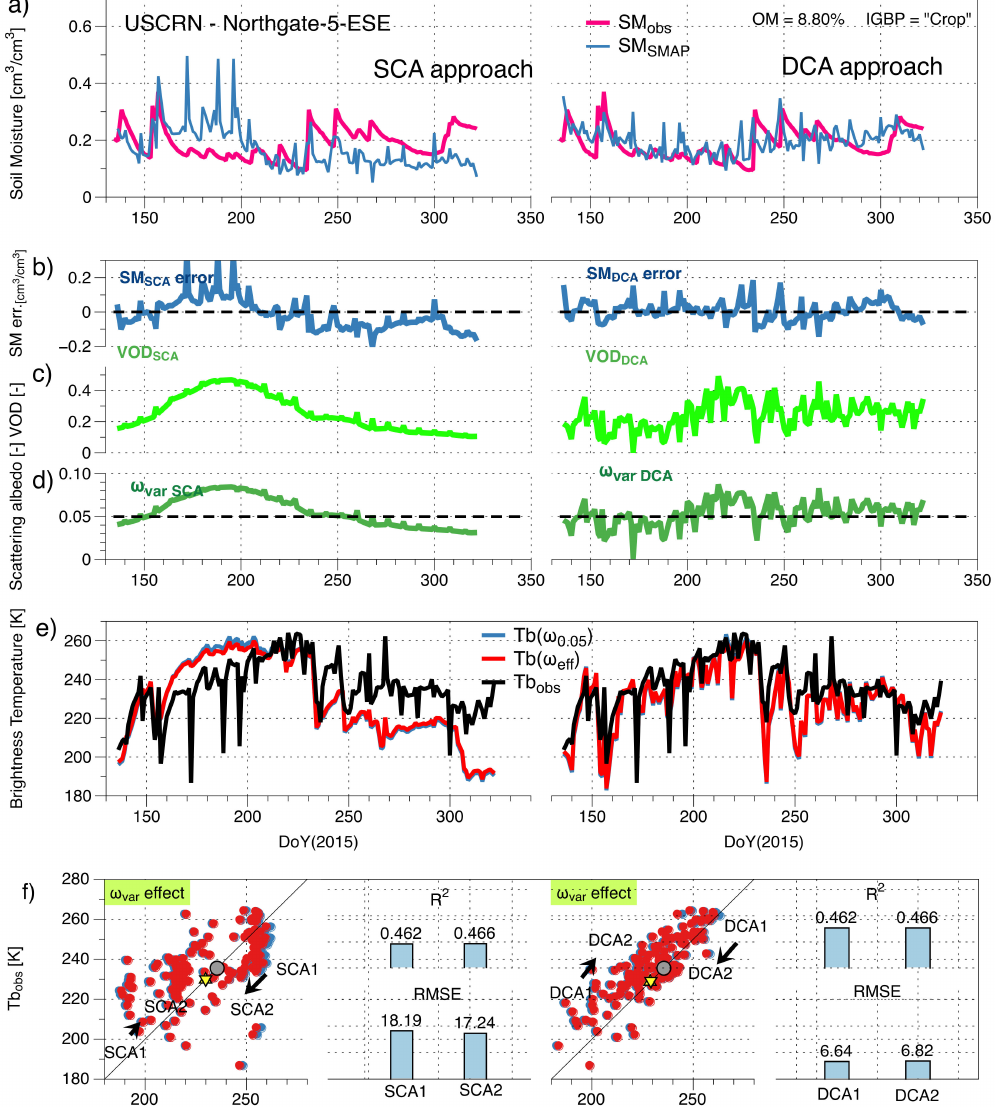
Figure 5. Validation of the improvement by applying time-varying ω within SCA and DCA